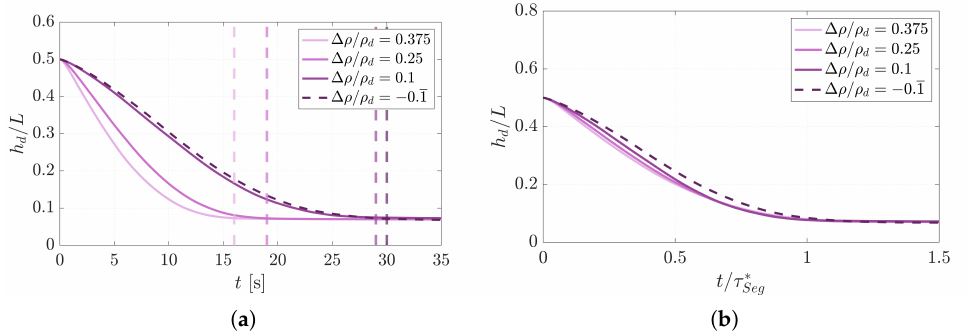
Figure 10. Temporal evolution of h d / L over time in ( a ), and over the normalized time in ( b ). The vertical lines, with the same color code as the solid lines, in ( a ) represent the respective time t seg , at which the segregation is